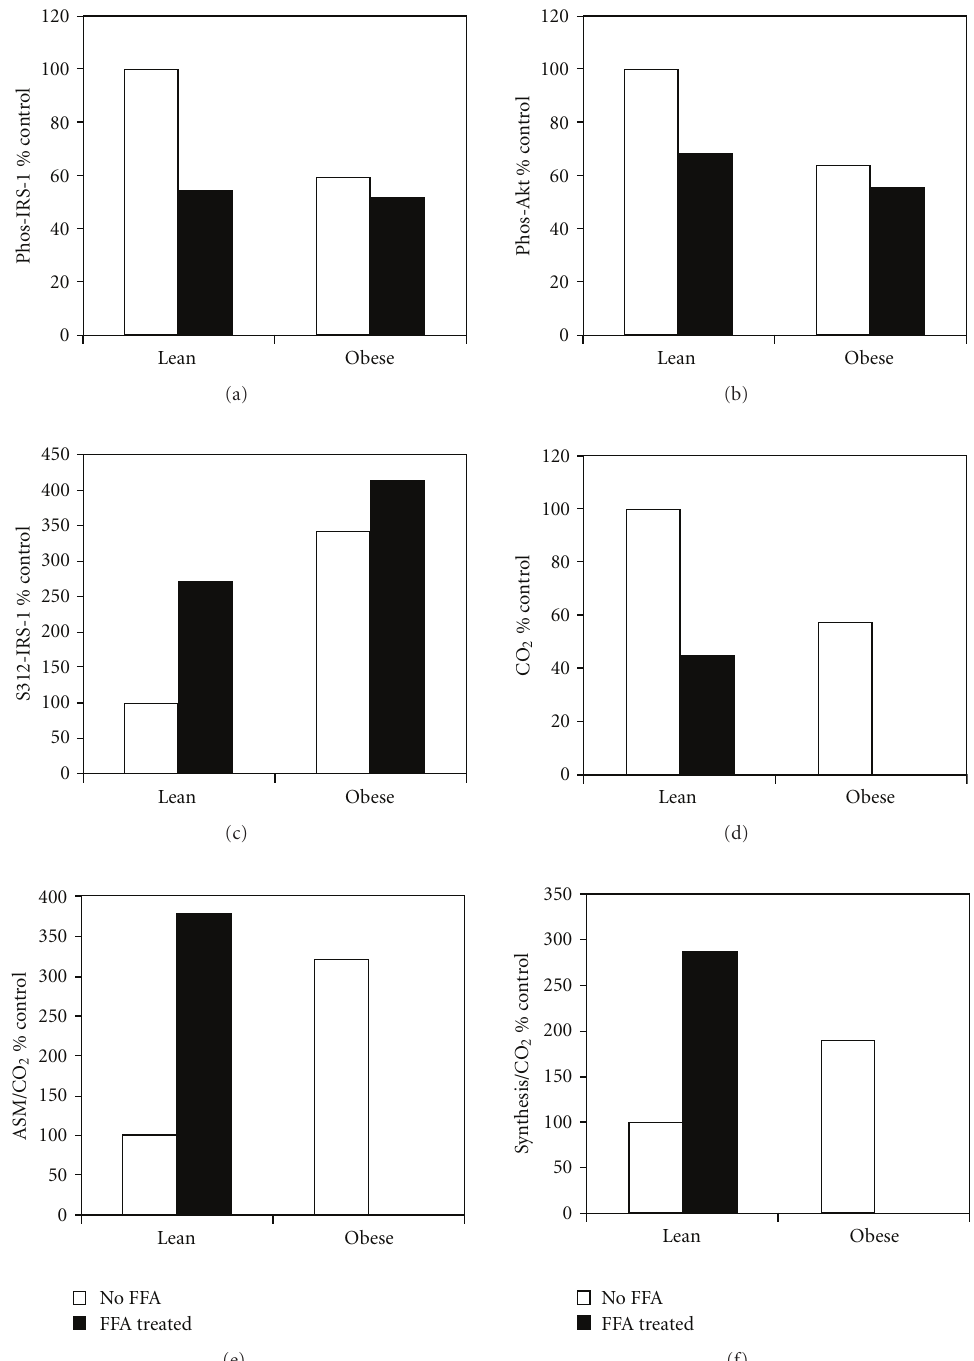
Figure 2: Comparison of insulin signal transduction and fatty acid metabolism in human cultured skeletal muscle cells (HSkMC) from lean and severely obese individuals that were incubated in the presence or absence of free fatty acids for 16 hours. The values shown in the graphs were calculated from mean values in published papers. The values for muscle cells from lean individuals in the absence of fatty acids were used as 100%. (a) Insulin stimulated tyrosine phosphorylation of IRS-1 (Phos-IRS-1) [44]. (b) Insulin stimulated Akt phosporylation (Phos-Akt) [44]. (c) IRS-1 serine 312 phosphorylation (S312-IRS-1) [44]. (d) Complete fatty acid oxidation as determined from labeled CO 2 production from 14 C labeled palmitate (CO 2 ) [43, 45]. (e) Incomplete fatty acid oxidation from calculating the 14 C from labeled palmitate remaining in the acid soluble metabolite fraction divided by labeled CO 2 production (ASM/CO 2 ) [43, 45]. (f) Partitioning between lipid synthesis and fatty acid oxidation (synthesis/CO 2 ) [25, 30, 43,